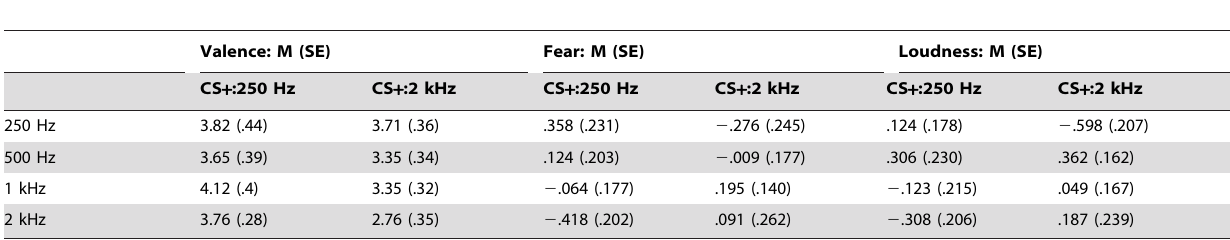
Table 1. Mean valence, fear and loudness ratings for the auditory stimuli according to the two conditioning groups (CS + : 250 Hz vs. CS + : 2